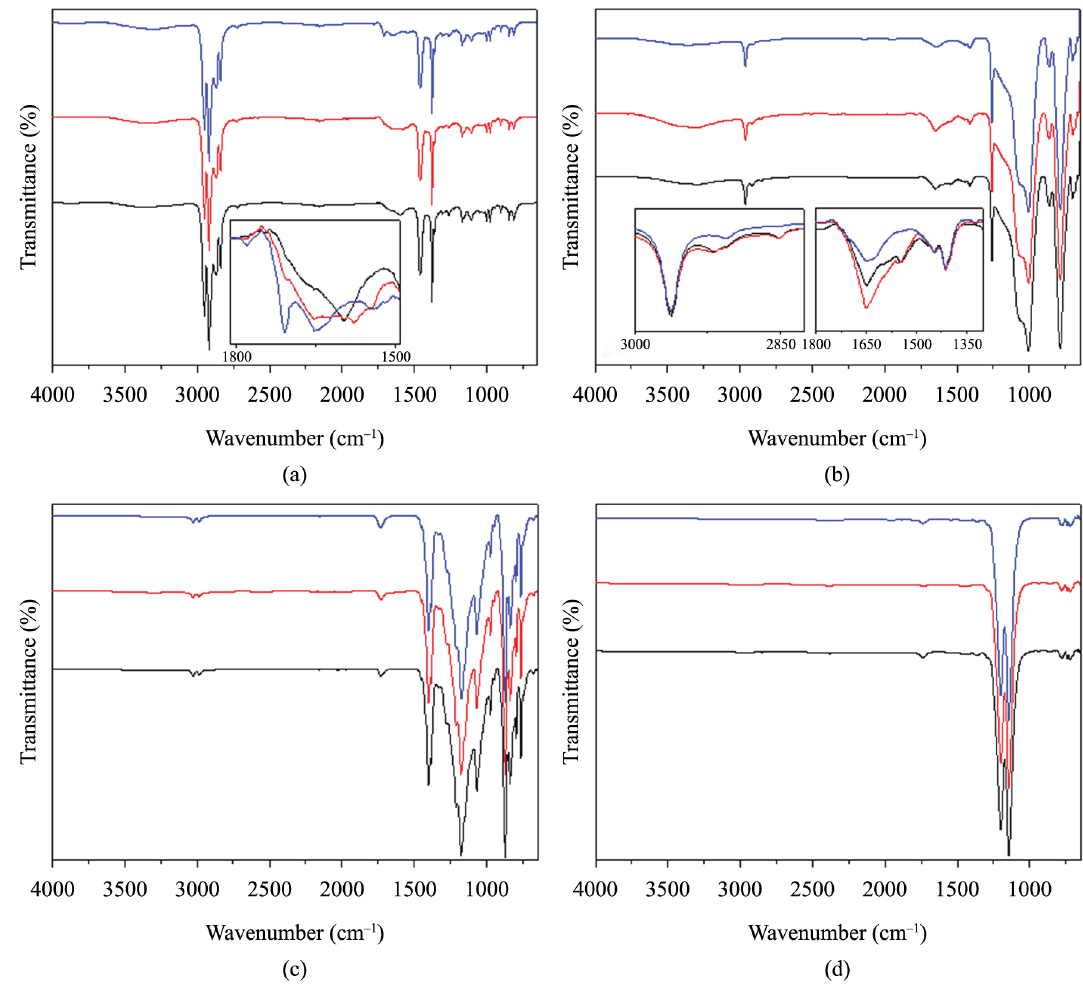
Figure 5. FTIR spectra of selected membranes. (a) PP; (b) PDMS; (c) PVDF and (d) PTFE. Black line is relative to sample without contact with ozone, red and blue lines to the sample after 2h and 4h of ozonation,